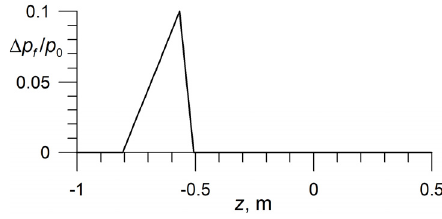
Figure 1. The initial pressure perturbation.